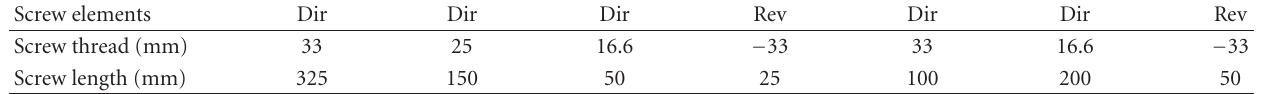
Table 2: Twin screw profiles with two restrictive elements (noted “Rev”) (profile 1).